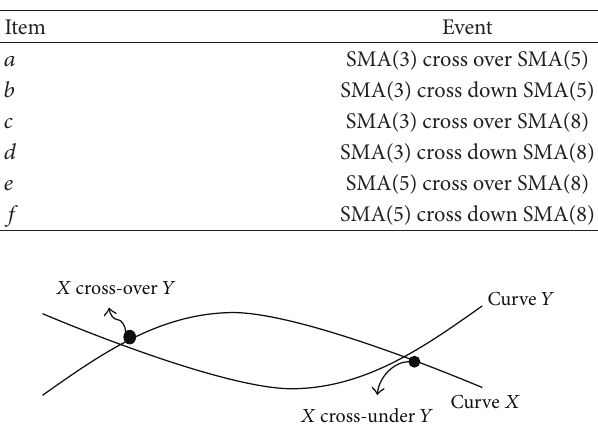
Table 5: The items of generated events in the experiment.